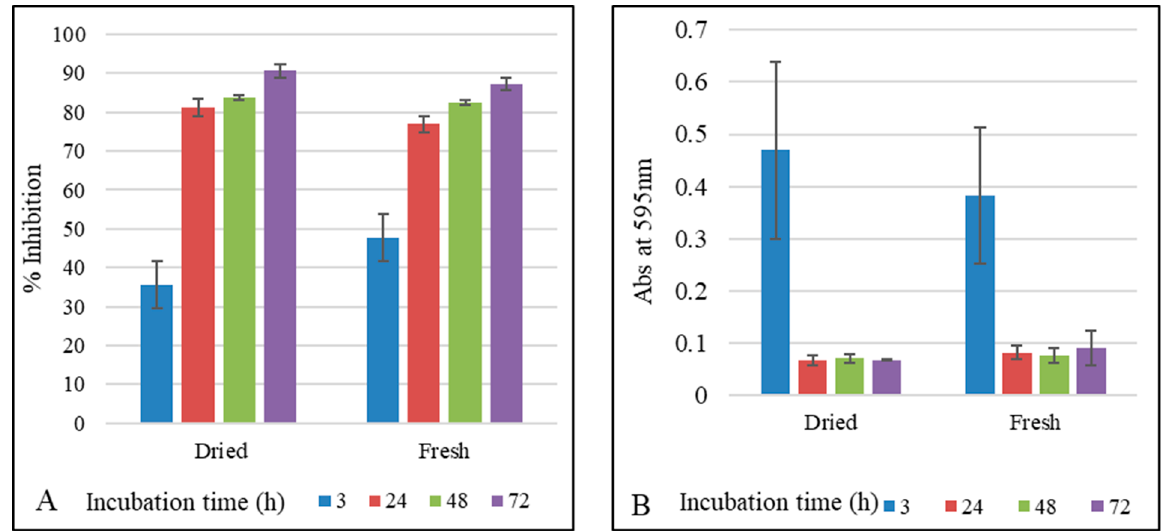
Figure 3. ( A ) Inhibition percentage of HCT 116 Cell line in the presence of 1:100 dilutions of dry and fresh extracts at 3, 24, 48, and 72 h incubation times. ( B ) Viability of HCT 116 cells using MTT assay in the presence of 1:100 dilution of dry and fresh leaf extracts after 3, 24, 48, and 72 h of incubation.